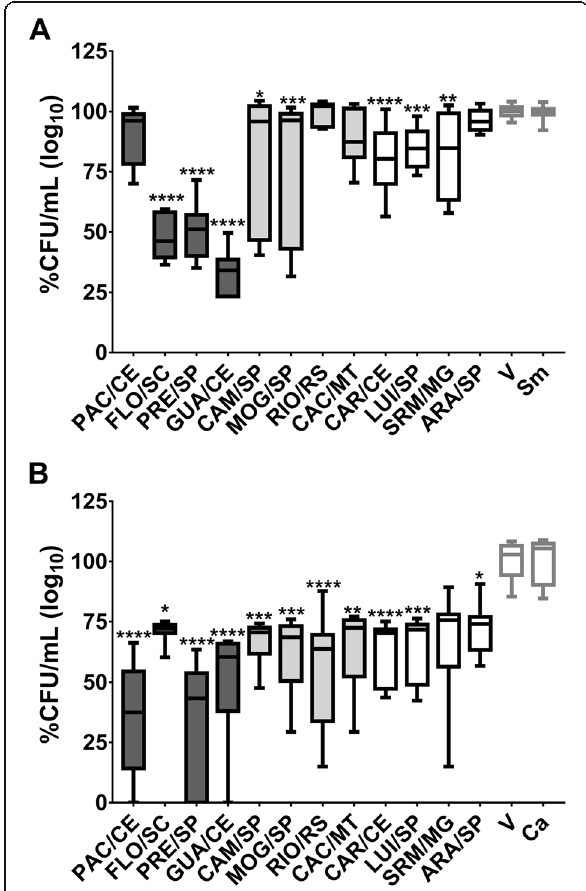
Fig. 2 Antimicrobial activity of C. sylvestris extracts from Brazilian biomes against S. mutans and C. albicans . a shows S. mutans data while ( b ) depicts C. albicans data. The data are median (traces) and interquartis (boxes) for the 12 extracts evaluated. The error bars represent the maximum and minimum values. Asterisks denote statistically significant difference of a specific extract versus vehicle (V) control, where: **** p ≤ 0.0001; *** p ≤ 0.001; ** ≤ p < 0.01; and * p ≤ 0.05 (Kruskal-Wallis test, followed by Dunn ’ s multiple comparisons test). Each species growth control (without treatment) is represented as Sm for S. mutans and Ca for C. albicans. The colors of the bars in each graph represent the variety to which the extracts belong, being, in dark gray color: var. sylvestris ; light gray: var. intermediate and white: var .